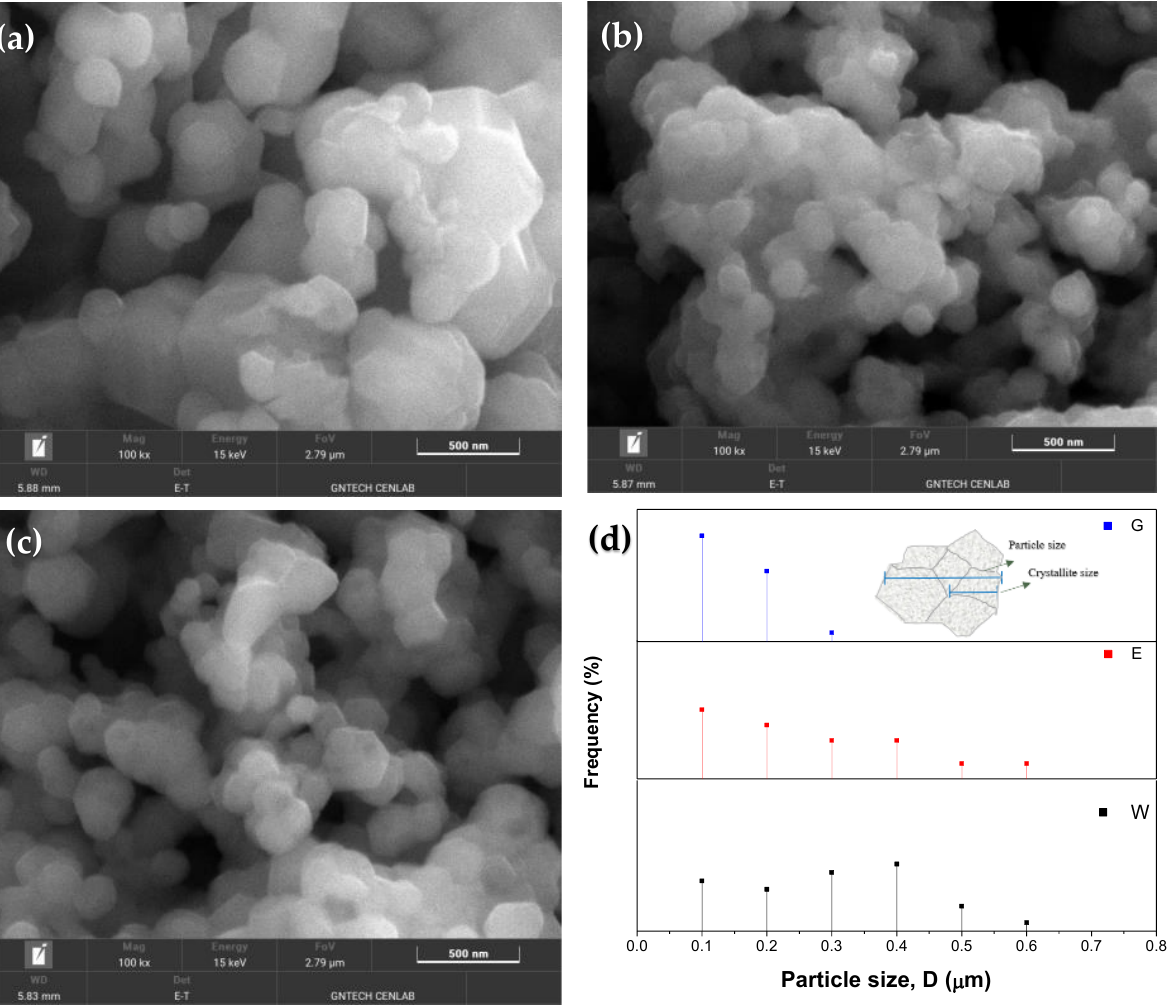
Figure 1. SEM images of ( a ) LMO-W, ( b ) LMO-E, and ( c ) LMO-G powders. ( d ) Particle-size distribution for all samples.